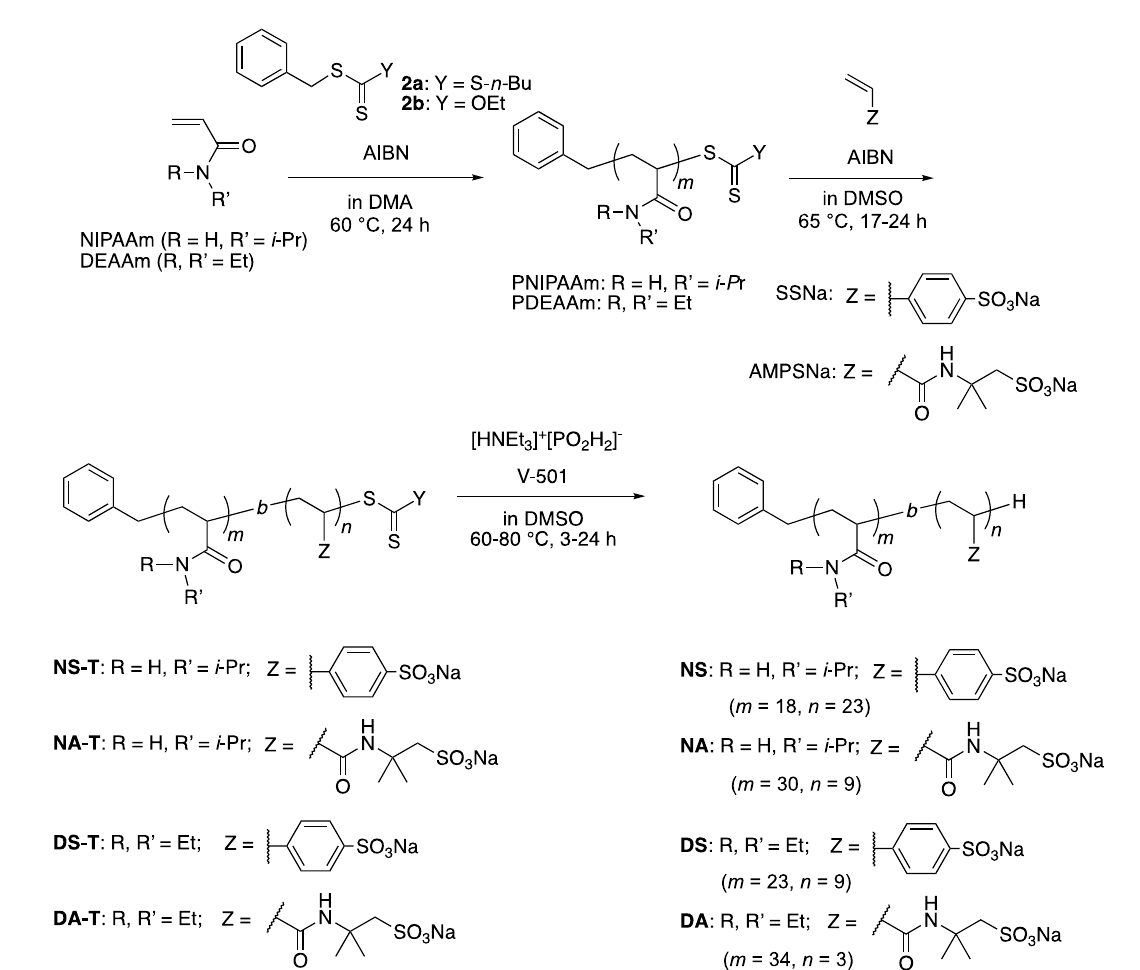
Scheme 1. Synthesis of thermoresponsive diblock copolymers.